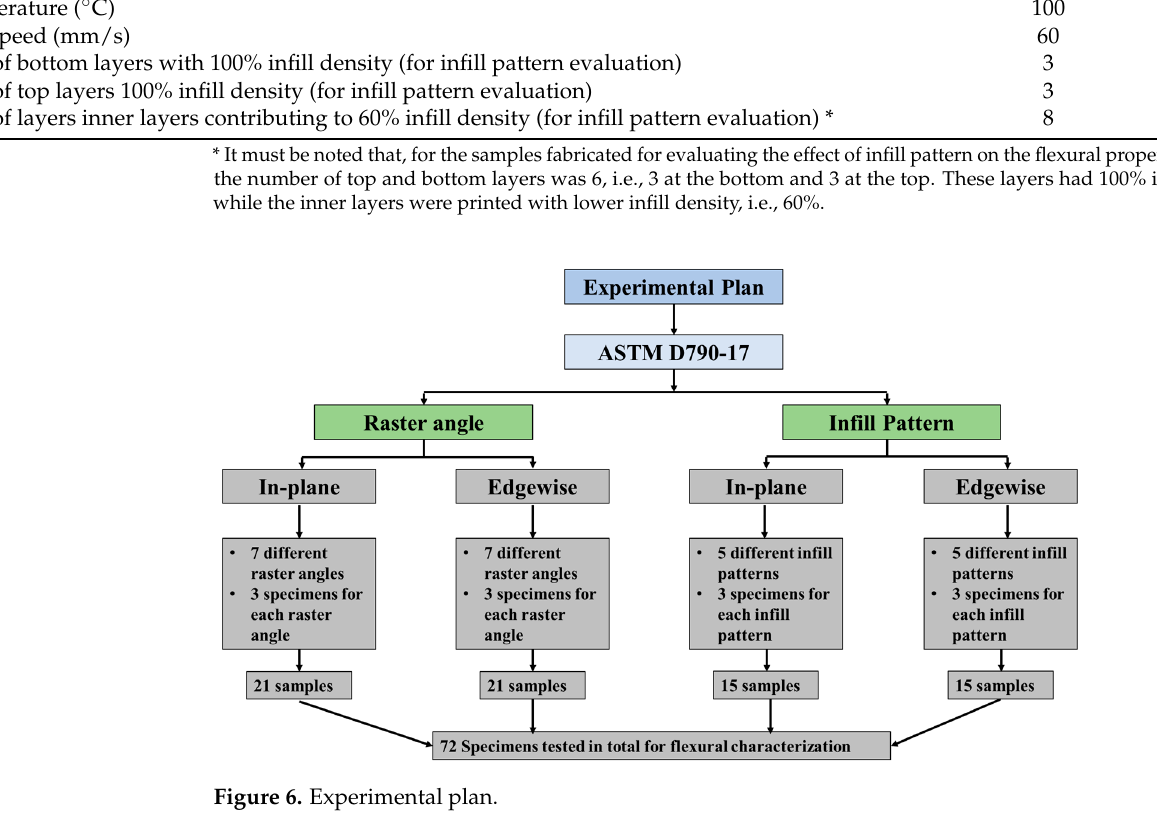
Figure 6. Experimental plan.